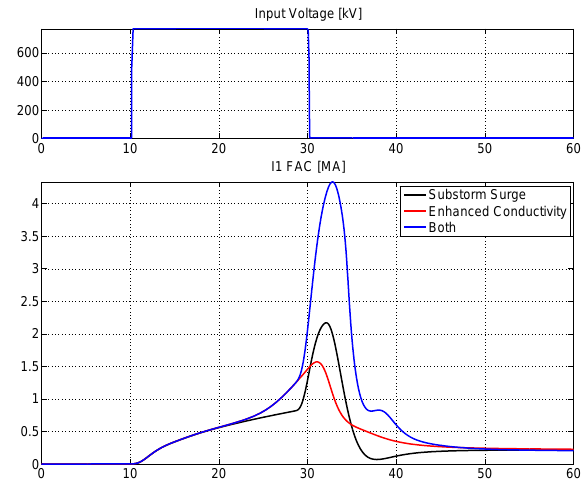
Fig. 1. The response of the magnetosphere–ionosphere field-aligned current system simulated by the WINDMI model for the case with a reconnection switch (shown in black), or the enhanced conductivity (shown in red), or both (shown in blue).